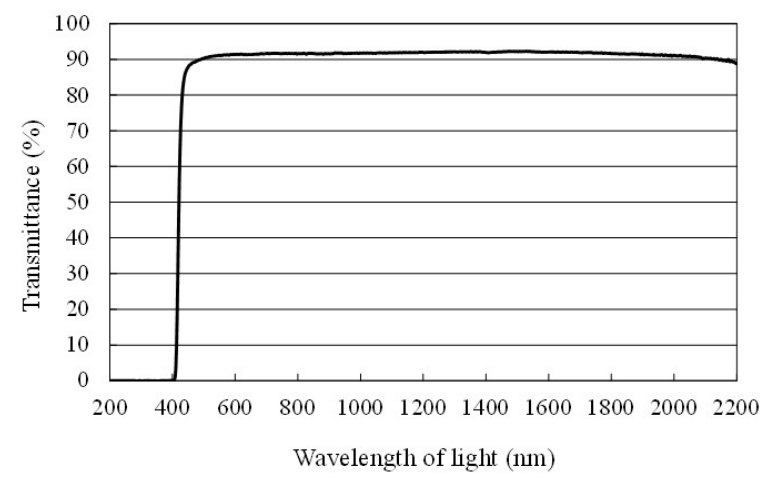
Figure 11. Light transmittance characteristics of sharp cut filter. The filter can cut off the wavelength of light which is below 400 nm.